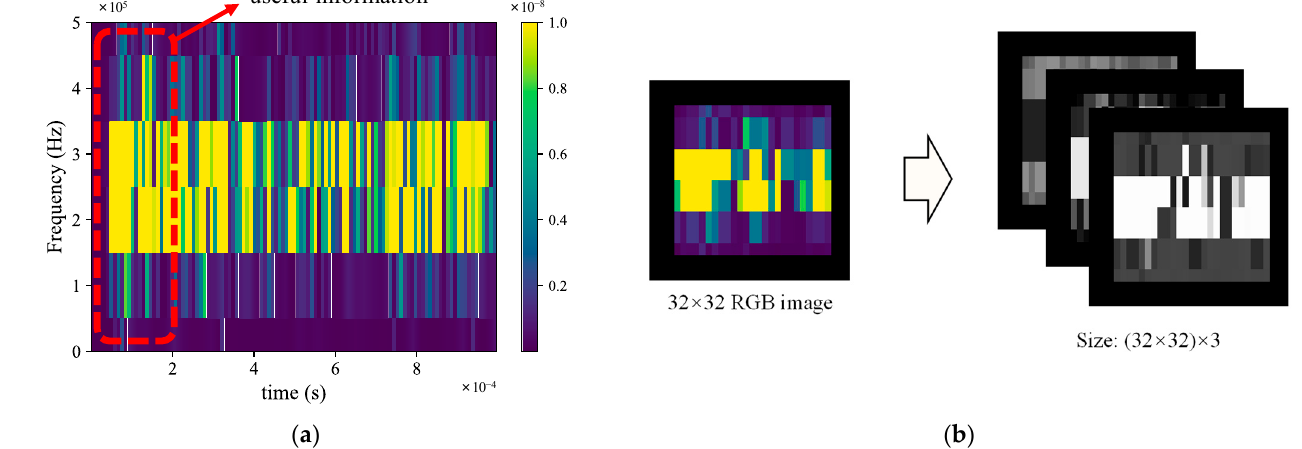
Figure 11. The imaging data pre-processing: ( a ) 2-D spectrogram with a color bar; ( b ) the extracted RGB image as the input of CNN.